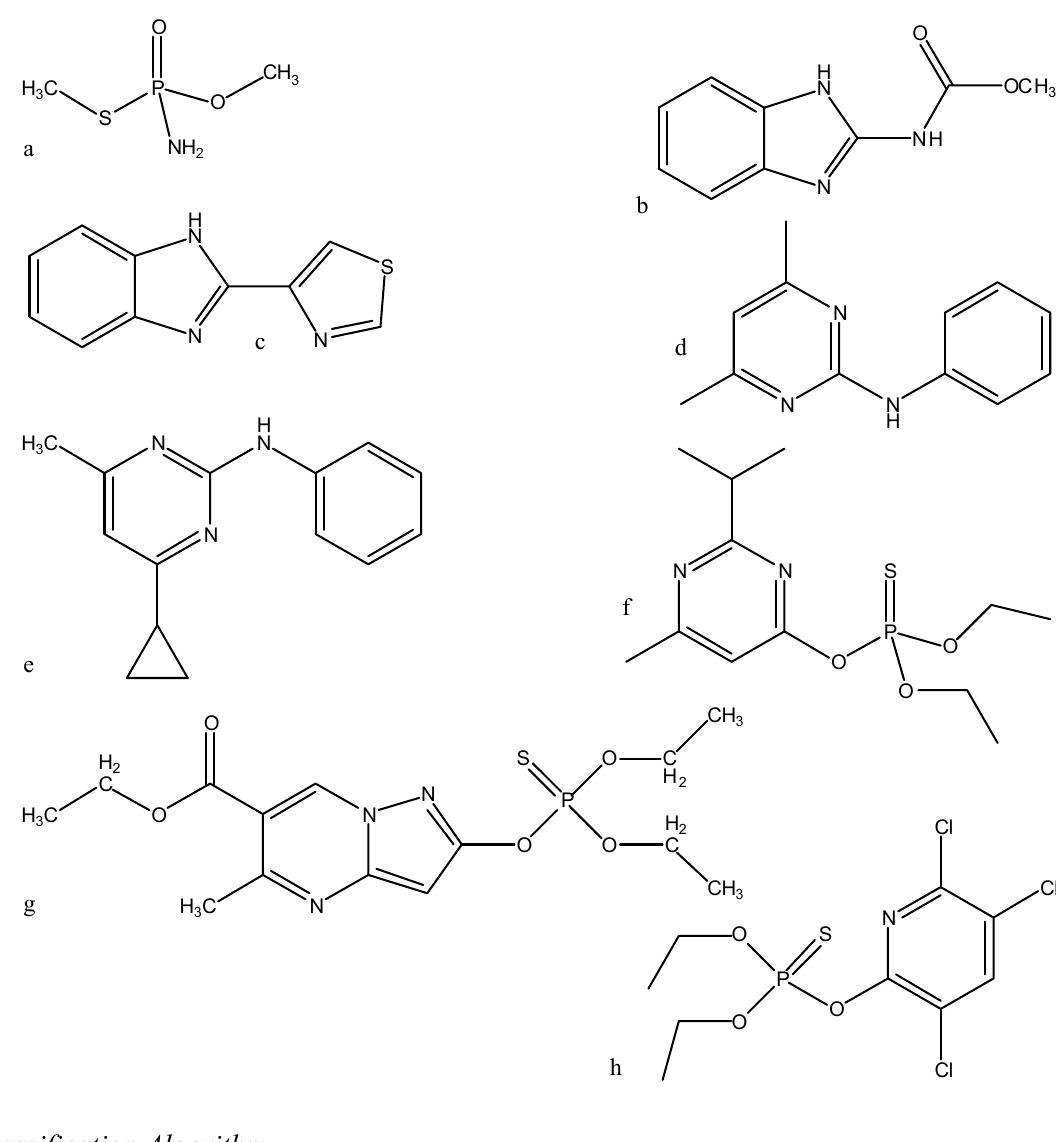
15. Pesticides: ( a ) methamidophos, ( b ) carbendazim, ( c )